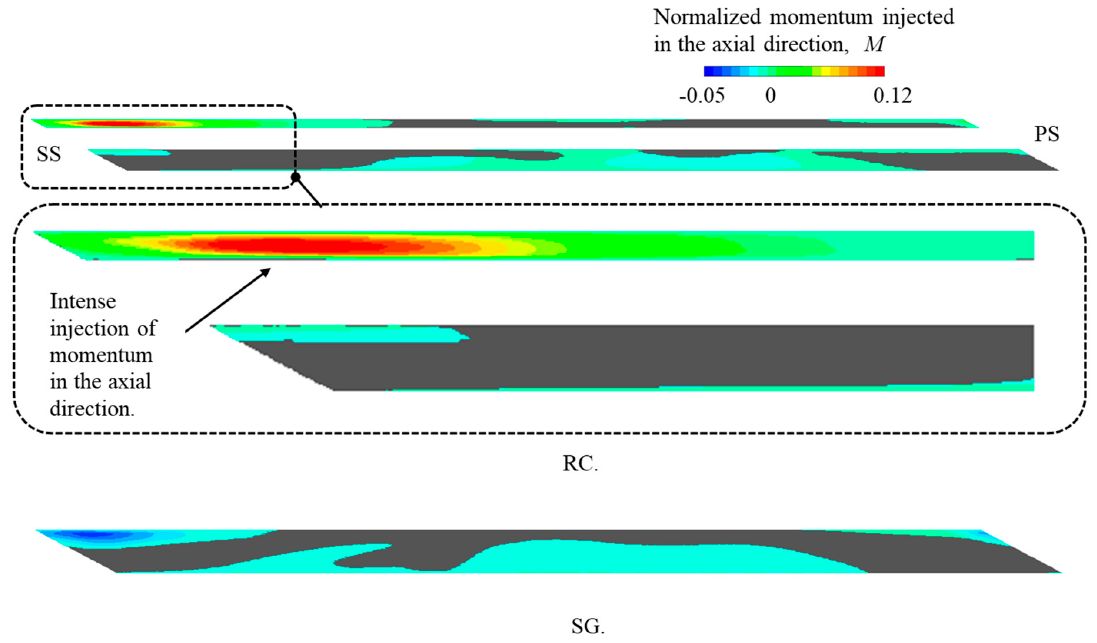
Figure 14. Distribution of the injected momentum in the axial direction showing an intense injection near the blade SS (OP-D).